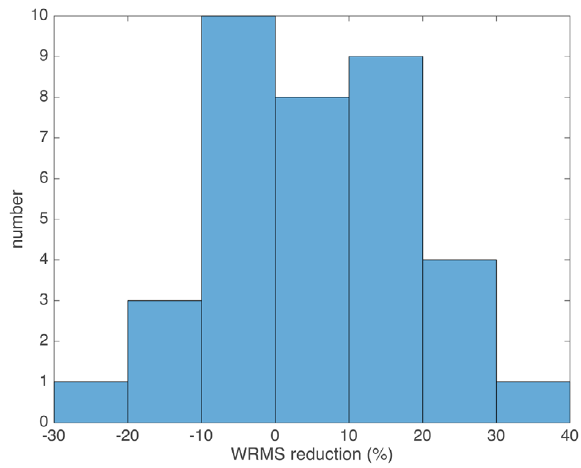
Figure 6. Distribution of WRMS reductions